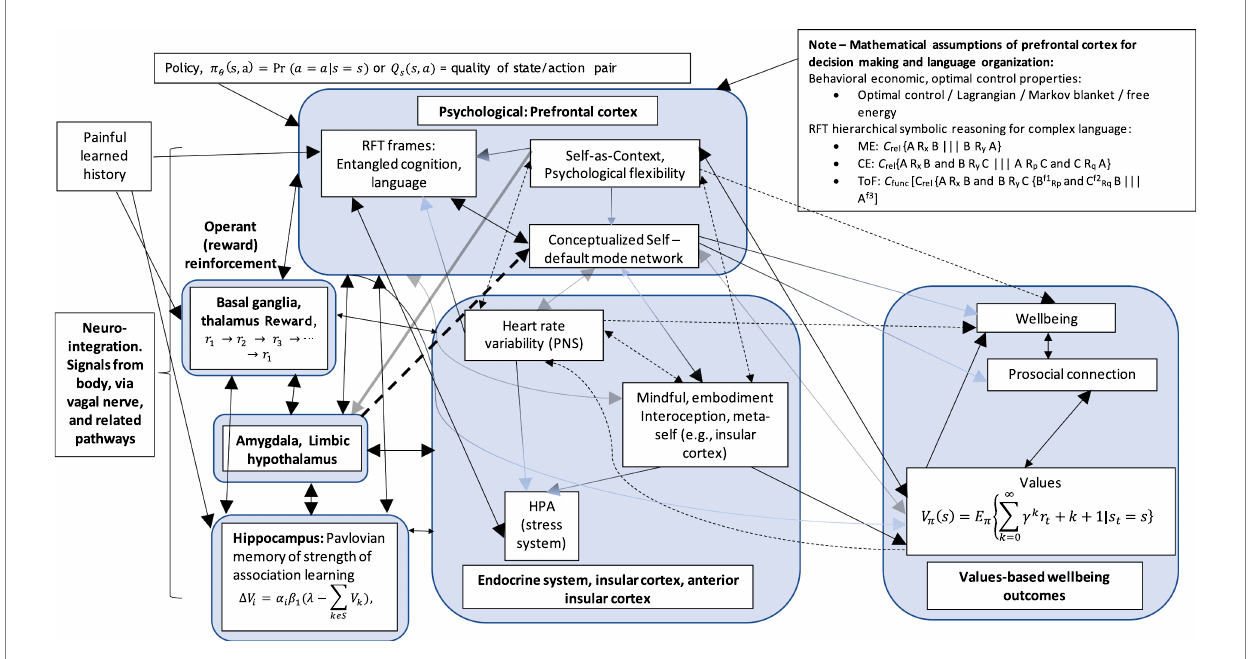
FIGURE 11 A potential example of a biopsychological level, neuro-integrated, and embodied network (NIEN). (1) Large arrowheads = greater excitatory effect; (2) Fading arrowhead = inhibitory effect; (3) Dashed line with directional arrowhead = mediating association; (4) Dashed line with bidirectional arrow heads = mediating or moderation